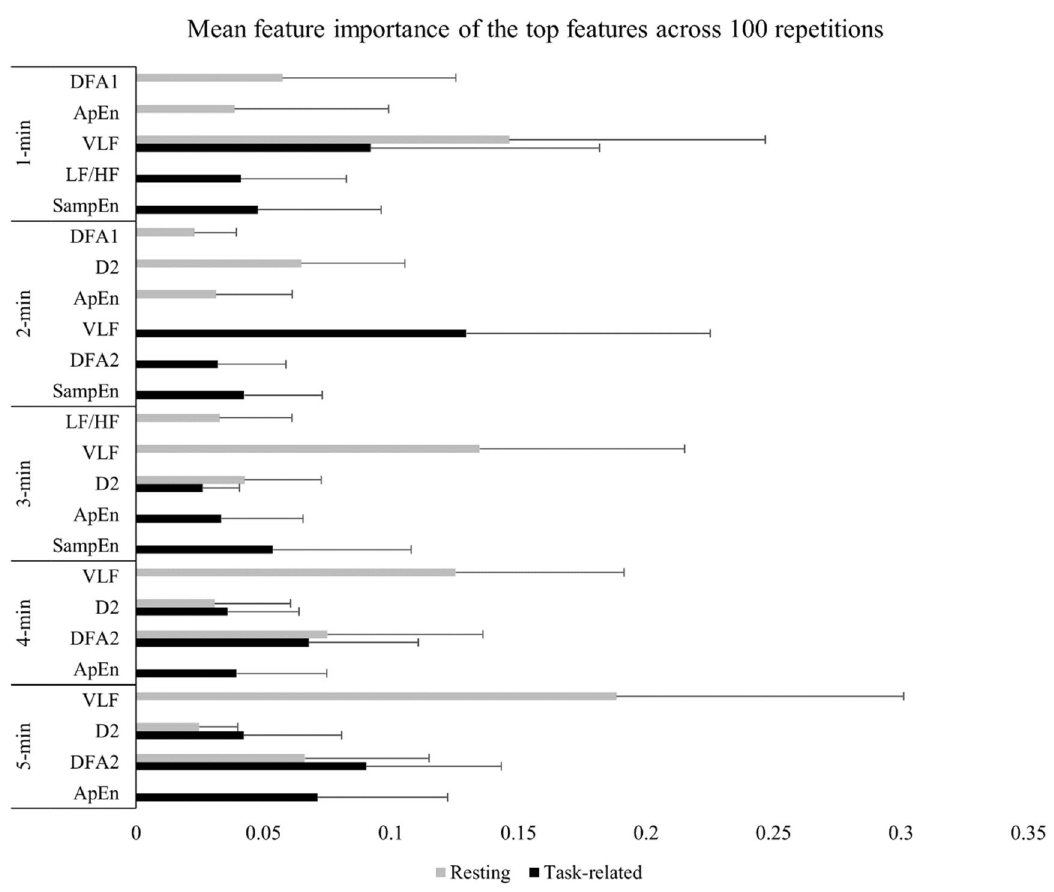
Figure 2. The top 3 most frequently selected features for classification. Error bars represent 1 standard deviation. ApEn approximate entropy, D2 correlation dimension, DFA1 short-term fluctuation obtained by detrended fluctuation analysis, DFA2 long-term fluctuation obtained by detrended fluctuation analysis, LF/HF ratio of the low and high-frequency components, SampEn sample entropy, VLF natural logarithm of the very low frequency